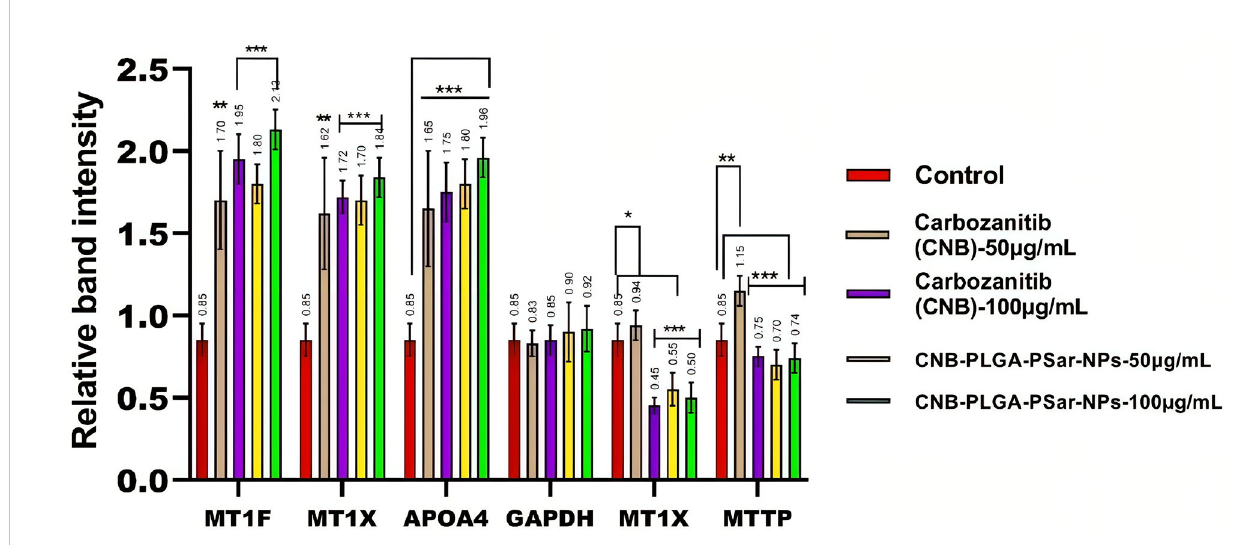
FIGURE 7 The expression levels of MT1F, MT1X, APOA4, MT1X, MTTP genes in relative to the reference gene; Glyceraldehyde 3-phosphate dehydrogenase (GAPDH) in HepG2 cancer cell line treated with the CNB-loaded CNB-PLGA-PSar-NPs and free CNB. *P< 0.05, **P< 0.01 and ***P< 0.001 vs. control was considered signi fi